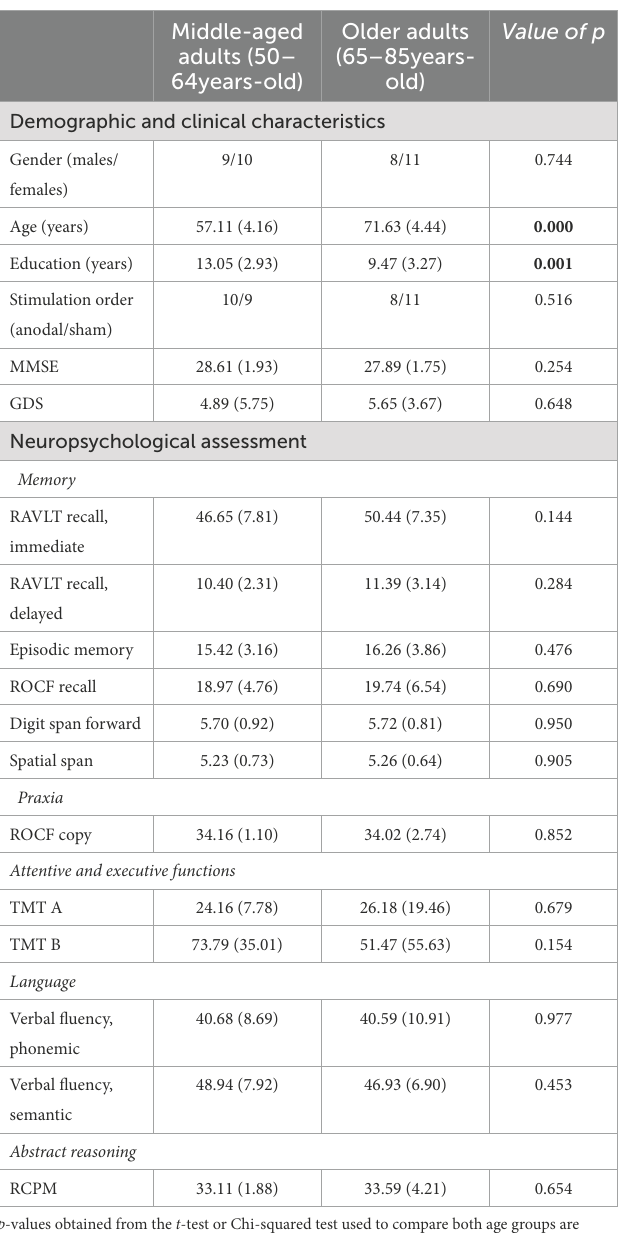
TABLE 1 Mean values and standard deviations (in parentheses) of the demographical, clinical and neuropsychological measures of the two groups of